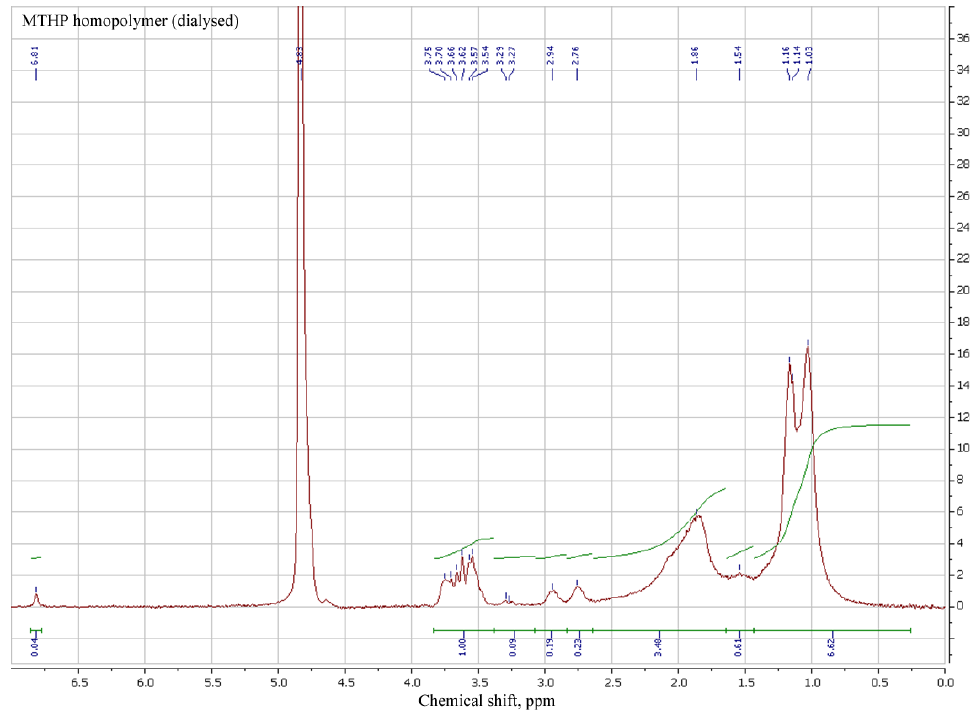
Figure 4. NMR 1 H spectrum of MTHP homopolymer in deuterated water after dialysis.